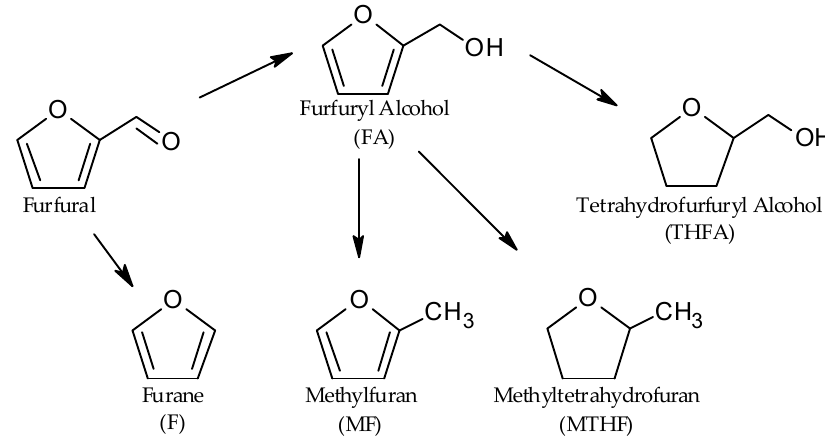
Figure 2. Possible reaction pathways for furfural hydrogenation. Table 1. Experimental conditions, conversion, and selectivity for liquid phase furfural hydrogenation in toluene using the Pt/BC 3 wt % catalyst. FA: furfuryl alcohol; TOF: turn-over frequency; THFA: tetrahydrofurfuryl alcohol; MF: methylfuran; and F: furan.